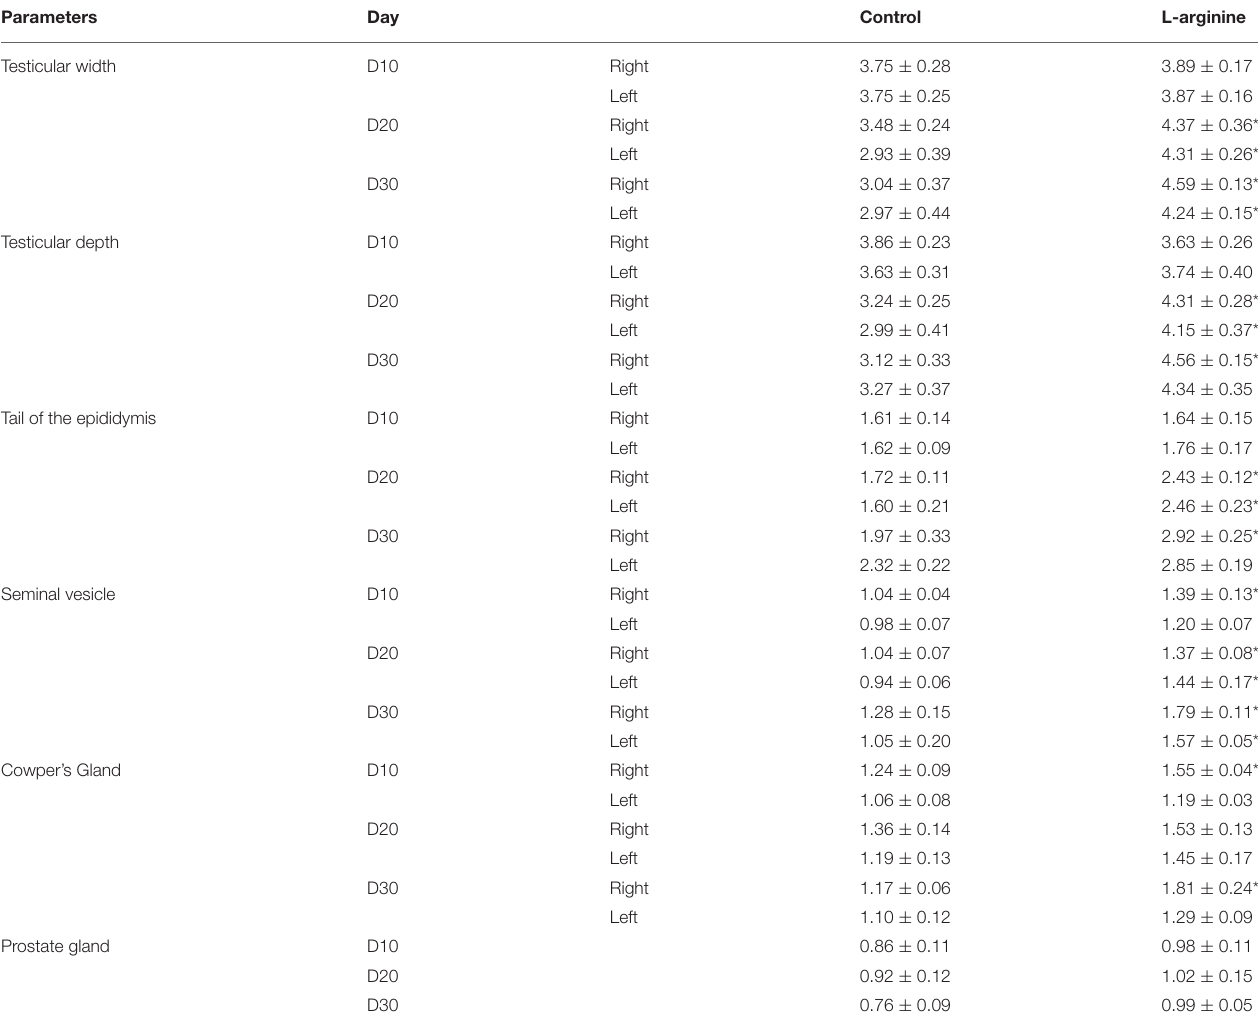
TABLE 1 | Ultrasonographic biometric measurements of the testes and accessory genital glands (both sides) in the control and L-arginine treated ram at days 10, 20, and 30 ( n = 5/group, mean ± SEM).